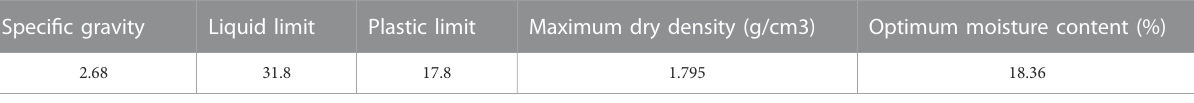
TABLE 1 The main physical and mechanical indices of the CBS as used in this study.